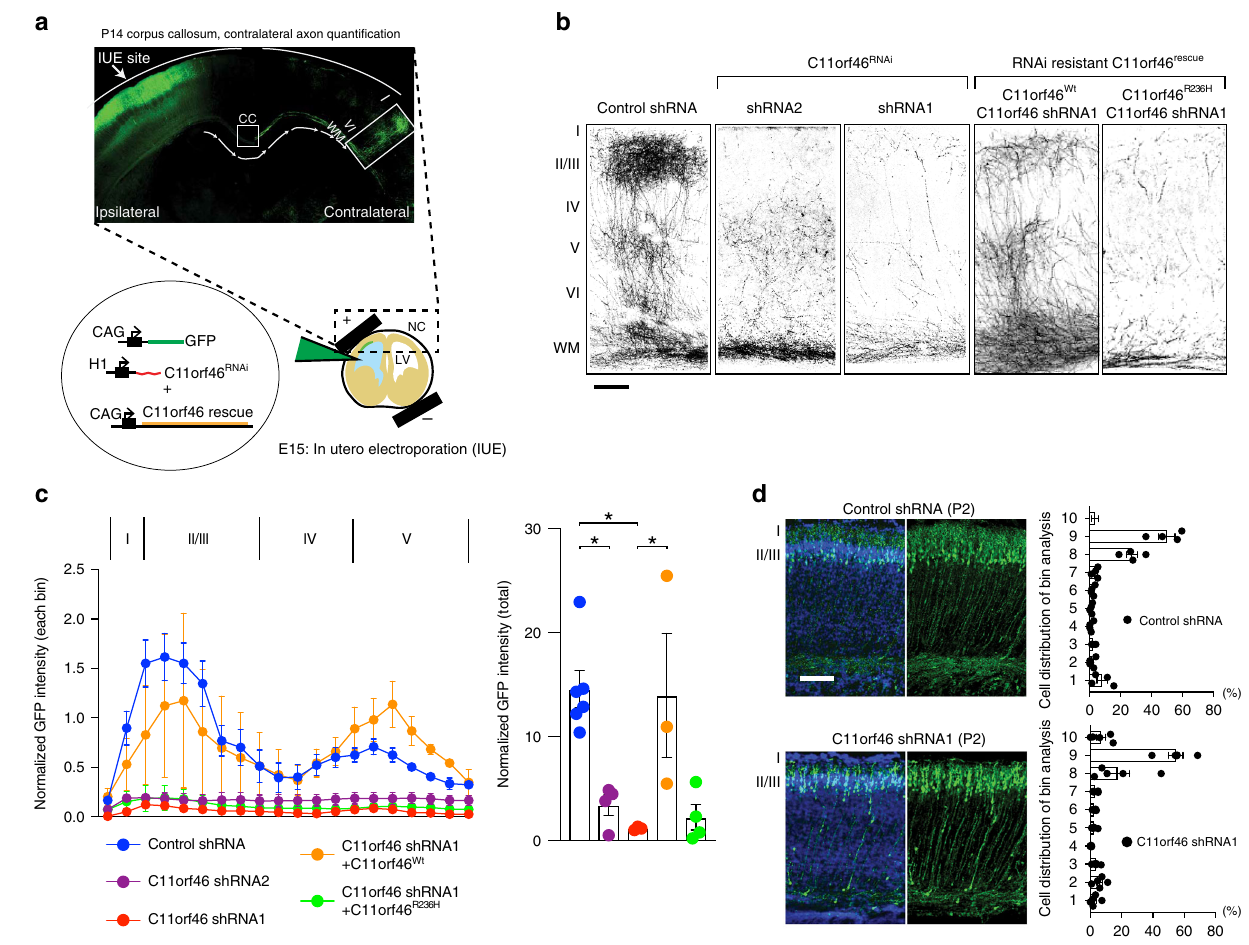
Fig. 2 Suppression of C11orf46 impairs callosal development and interhemispheric connectivity. a (top) Schematic representation of in utero electroporation of GFP expressing plasmid into somatosensory cortex at E15. (bottom) P14 somatosensory cortex expressing GFP in pyramidal neurons at IUE injection site (Ipsilateral side) and axonal projections between layer I – VI (Contralateral side). b Knockdown of C11orf46 in pyramidal neurons of layer II/III (Ipsilateral) show impaired axonal terminal arborization in the contralateral somatosensory cortex at P14. C11orf46 shRNA1 had a stronger axonal arborization impairment than shRNA2 when compared with control shRNA ( fi rst 3 panels); this axonal de fi cit was partially rescued by co-expressing RNAi resistant wild-type C11orf46 (C11orf46 Wt ), but not by R236H mutant (C11orf46 R236H ) (last 2 panels). Scale bar, 100 µ m. c Layer distributions (left) and total axonal density (right) of callosal axons in the contralateral site of the electroporated brains were shown as normalized immuno fl uorescence intensities of callosal axons. F (4, 15) = 7.9591, P = 0.0012 was determined by one-way ANOVA with post hoc Bonferroni test. Three to six mice per condition. * P < 0.05. Impaired axon terminal arborization across all cortical layers elicited by C11orf46 knockdown was restored by overexpression of C11orf46 Wt , but not by overexpression of C11orf46 R236H . d C11orf46 knockdown did not have an effect on radial neuronal migration at P2. Scale bar, 50 μ m. Bar graphs indicate mean ± S.E.M ( c , d